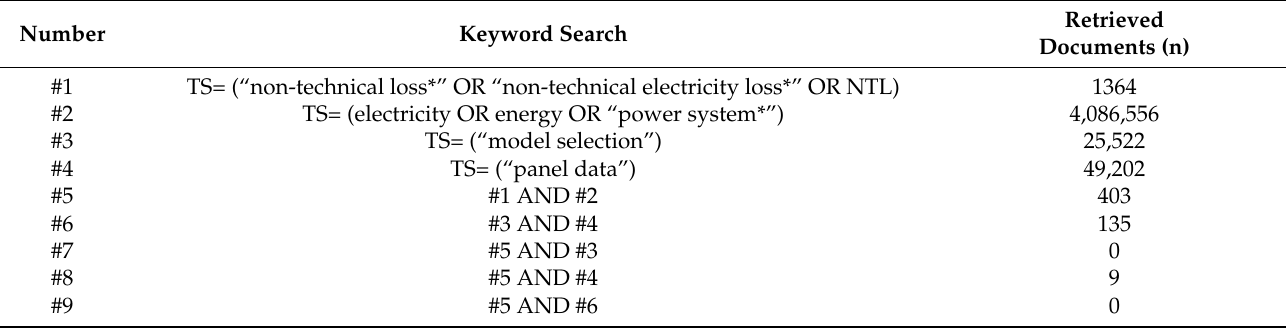
Table A1. Search strategy in the Web of Science database.